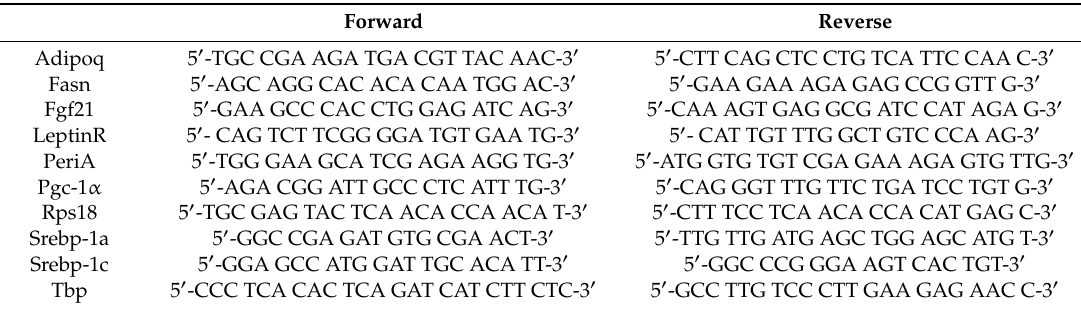
Table 1. List of primers for